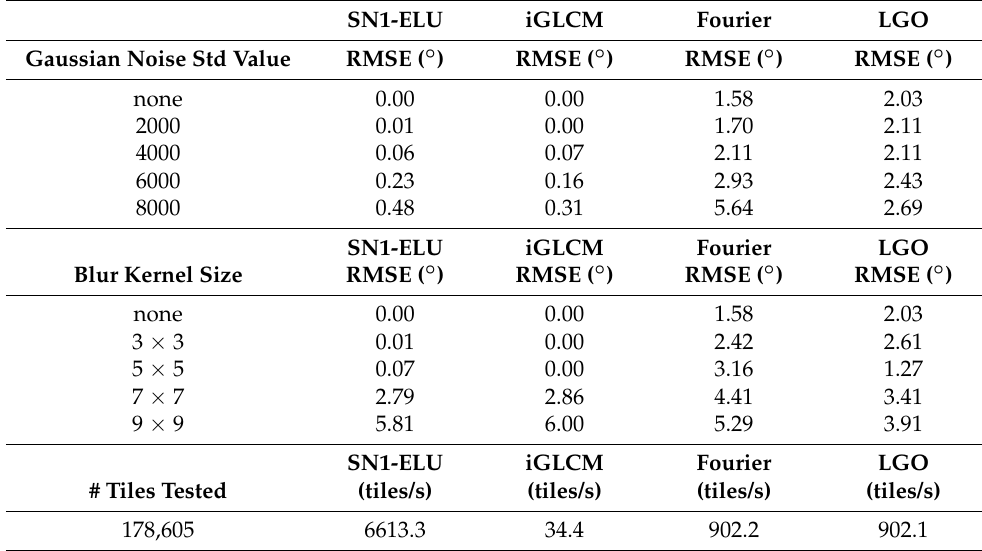
Table 4. Performance comparison (RMSE ( ◦ ) and speed (tiles/s)) between CNN, iGLCM Fourier and LGO-based directionality detection (same testing